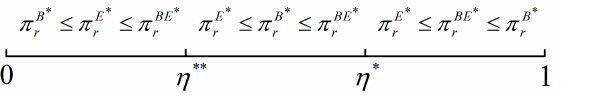
Figure A1. The relationship among π B r